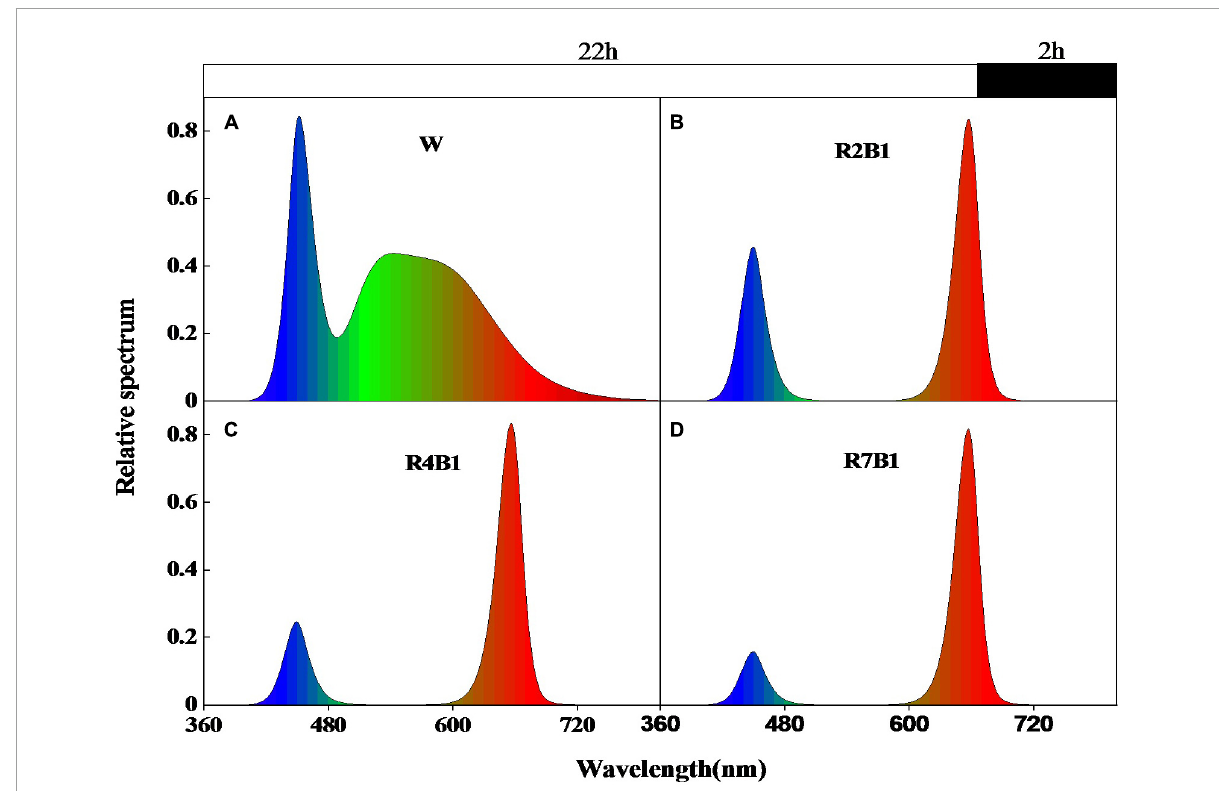
FIGURE1 Relative spectrum distribution of the four LEDs’ light quality combinations. (A) White light (W); (B) red-blue light ratio 2:1 (R2B1); (C) red-blue light ratio 4:1 (R4B1); (D) red-blue light ratio 7:1 (R7B1). The white box above the figure represents the light duration of 22 h, and the black box represents the dark time of 2